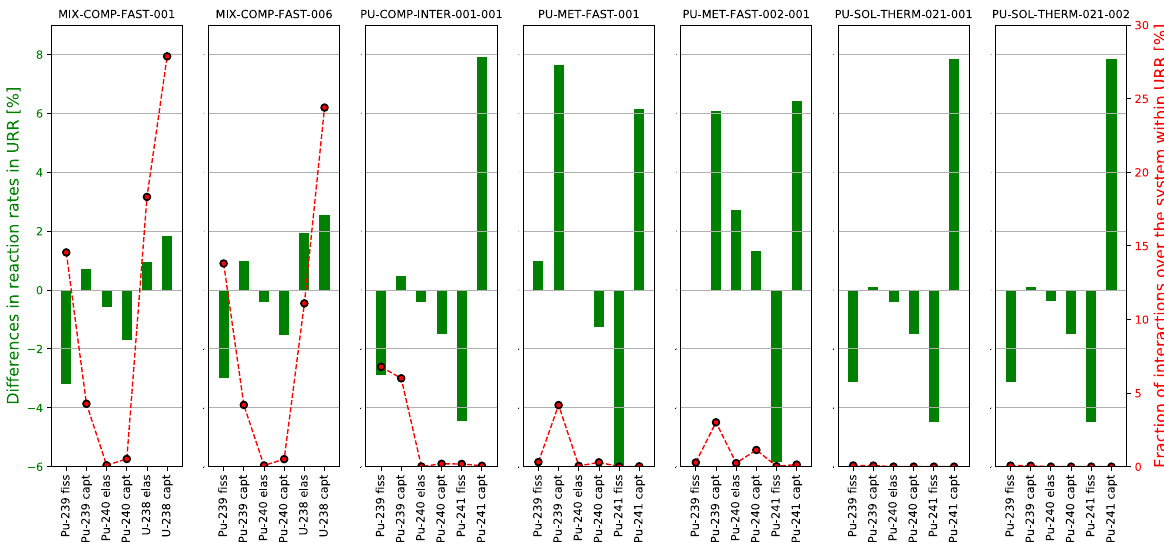
Figure 4. Differences in reaction rates in the URR with and without PT and fraction of interactions within the URR for MIX and Pu benchmarks. Relative values computed as (rr noPT – rr PT )/rr